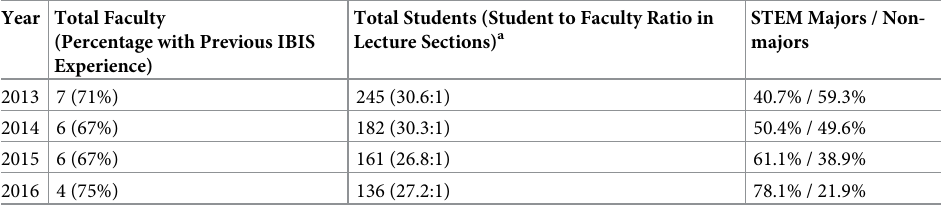
Table 1. Faculty and student participation in the IBIS